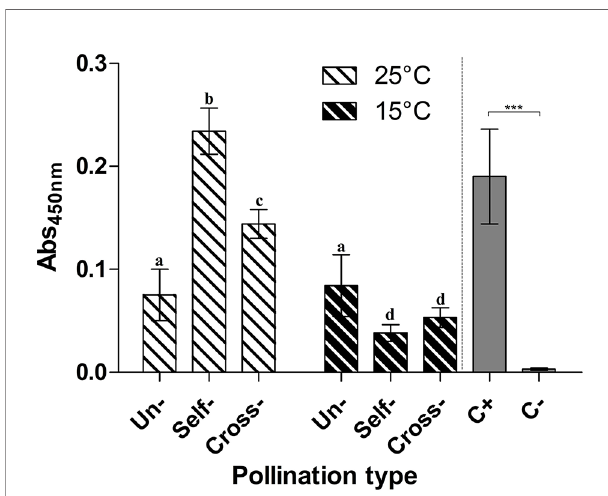
FIGURE 5 | Immunoquanti fi cation of pollen TGase cross-linked products. ELISA assay for the TGase isopeptide product N e -( g -glutamyl)-lysine. The presence of N e -( g -glutamyl)-lysine was tested in unpollinated, self-pollinated, and cross-pollinated pistils at 25°C and at 15°C, by the 81D4 monoclonal antibody. As a control, casein treated (C+) or not (C − ) with TGase was used in the same ELISA assay. Means ± S.D. of three experiments analysed in triplicate are reported. Samples indicated with the same letters are not signi fi cantly different. The data were analyzed by two-way ANOVA and Tukey ’ s post-test. A p value < 0.05 was regarded as statistically signi fi cant. Casein treated with TGase (C+) was signi fi cantly different from casein not treated with TGase (C − ) as demonstrated by one-way ANOVA. ***p <